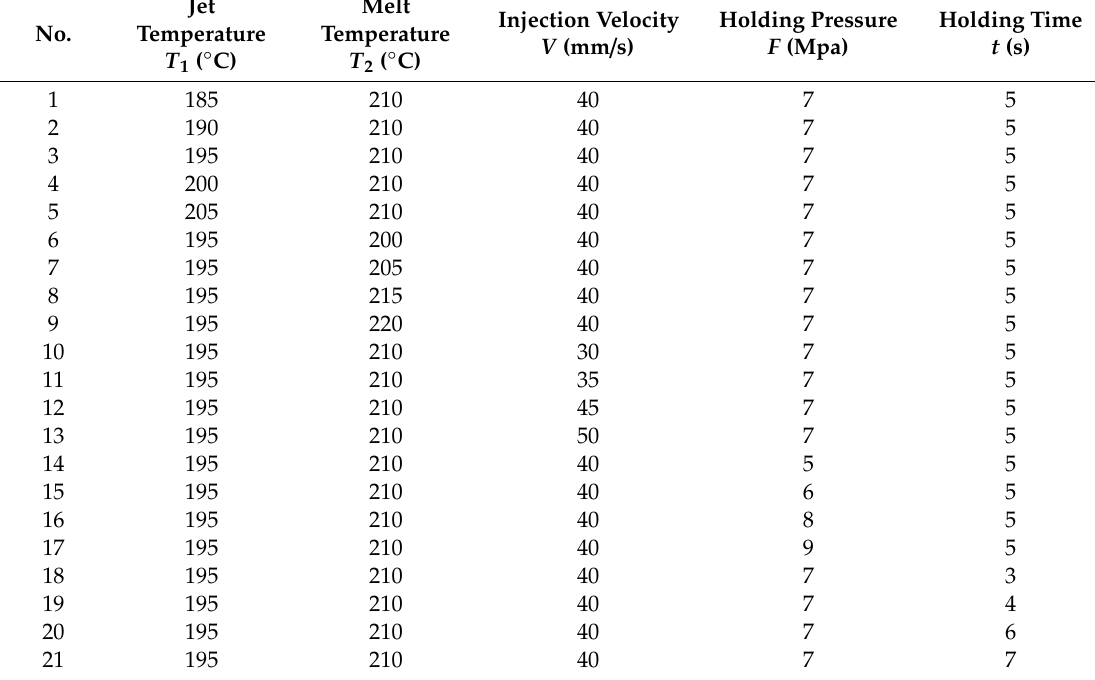
Table 1. The micro-injection molding parameters and corresponding levels in designed